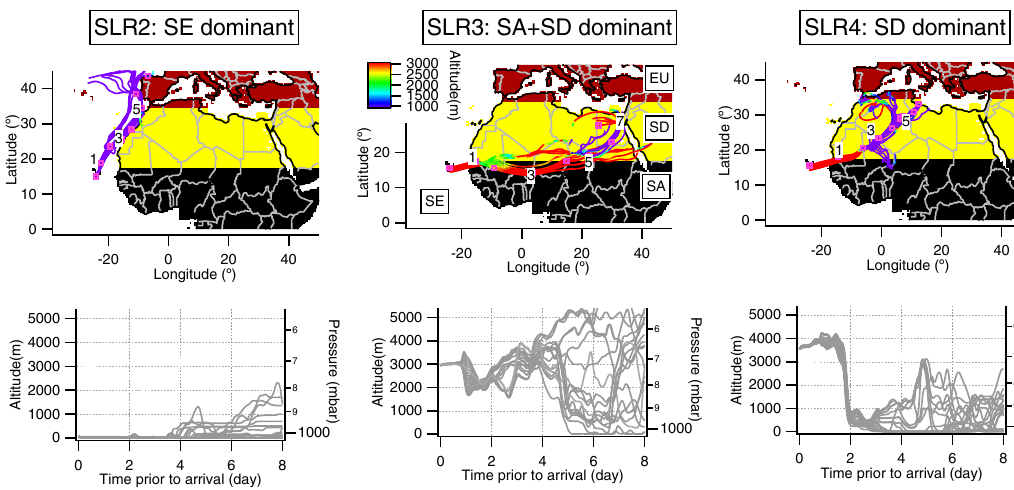
Figure 8. The BTs for the SLRs marked in the boxes in Fig. 7a.